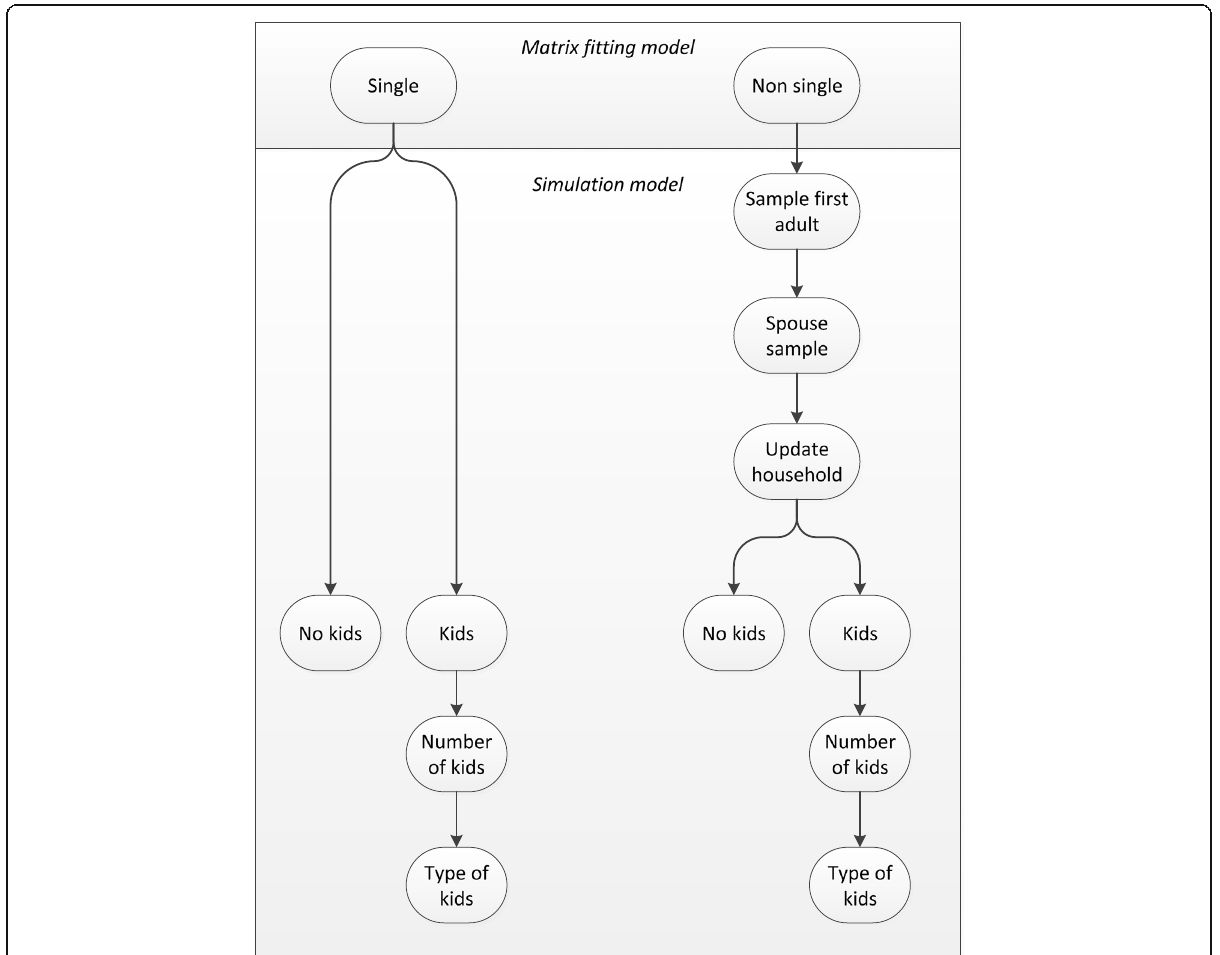
Fig. 3 Illustration of main steps in the micro-simulation